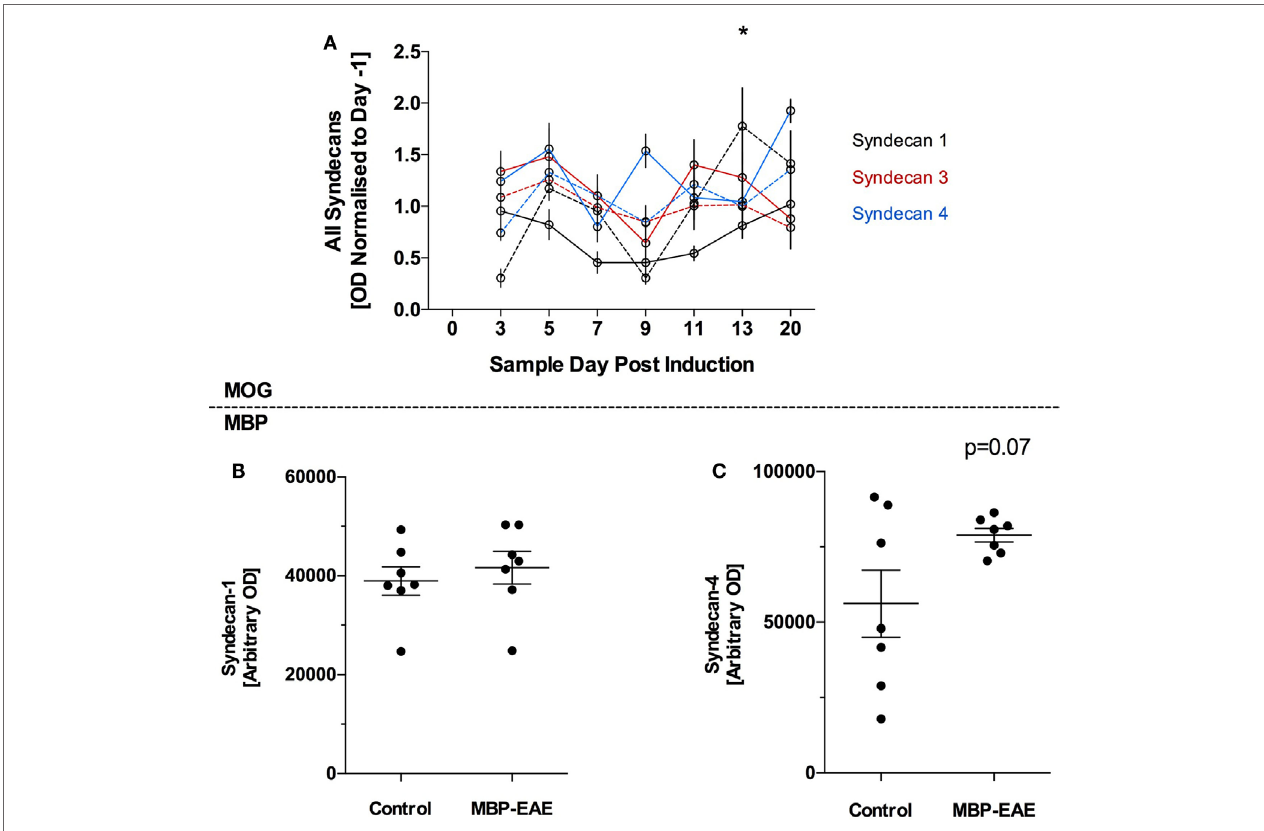
FigUre 3 | Protein-based glycocalyx (GLX) markers are largely unchanged in myelin oligodendrocyte glycoprotein (MOG)- and myelin basic protein (MBP)- experimental autoimmune encephalitis (EAE) in the initial stage of disease from induction until peak disease severity. GLX-based proteoglycans of the syndecan family were detected in the plasma of MOG- and MBP-EAE-induced rodents. In the MOG-EAE model (a) , levels of Syn-1 (black), Syn-2 (red), and Syn-4 (blue) were determined in controls (full line) and longitudinally until and at peak severity in disease (dotted line). In MBP-EAE, levels of Syn-1 (B) and Syn-4 (c) in controls and at disease peak severity were determined. (a) Inclusive of some day-to-day fluctuation, all three markers were relatively stable throughout the MOG-EAE disease course (a) . Nevertheless, Syn-1 was significantly increased in MOG-EAE at day 13. Syn-1 and -4 were not different in MBP-EAE at peak disease severity (B,c) . Syn-4 (c) tended to be higher than the control group but not significantly ( p = 0.07), wherein the control group had a high internal variability. Data are presented as line graphs (a) normalized to pre-EAE levels (day − 1) and (B,c) dot plots of control vs. EAE. Statistical significance is reported when p -value is < 0.05, where * refers to p < 0.05 after testing for normality (Shapiro–Wilk) and equal variance and running the following statistical analysis: (a) two-way ANOVA, (B,c) Student’s t